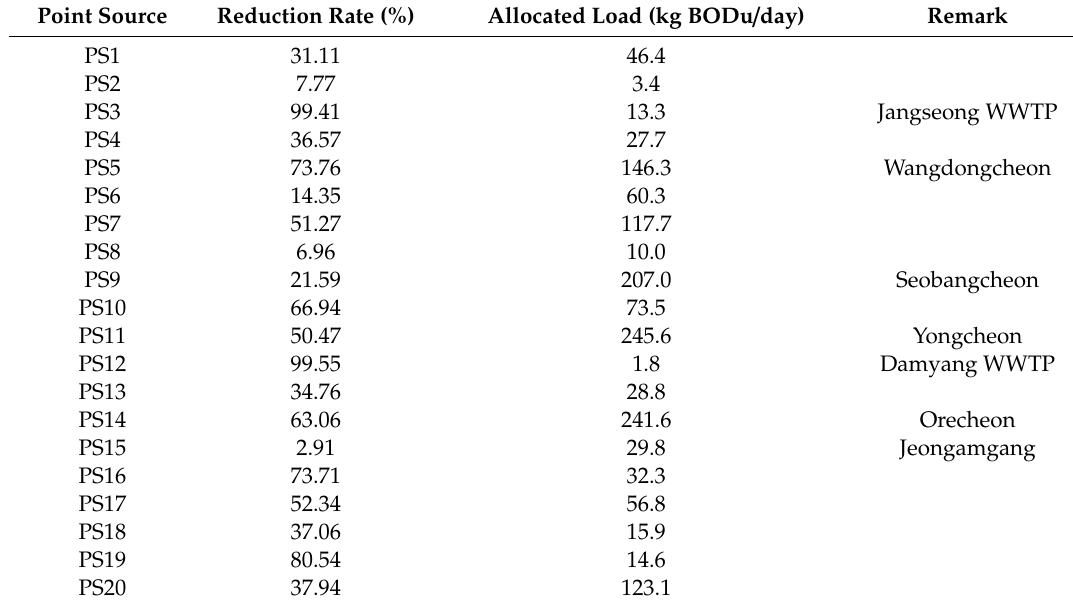
Table 1. Allocated biochemical oxygen demand (BOD) load calculated by the fuzzy waste load allocation